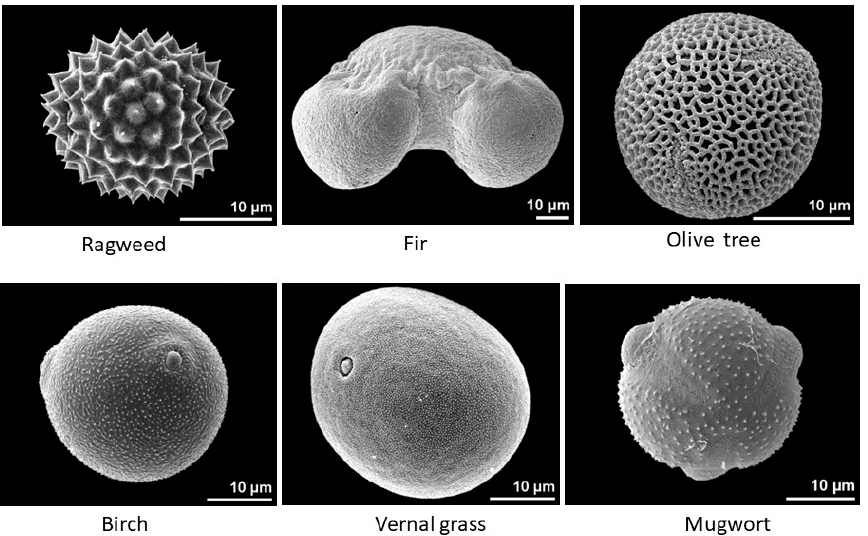
Figure 10. Images of some pollens, showing the diversity in their size and surface shape; images from the PalDat—Palynological Database [33].